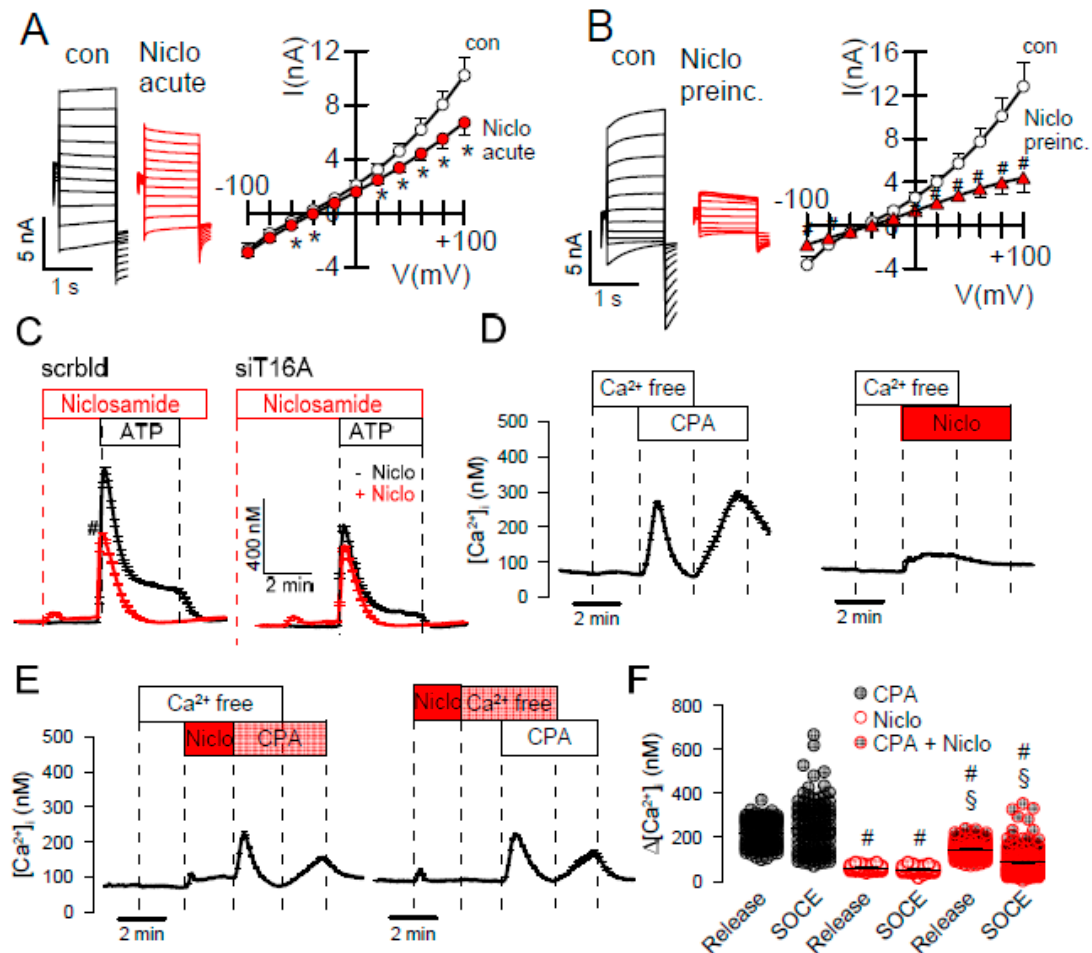
Figure 4. Niclosamide inhibits TMEM16A currents activated by intracellular Ca 2 + . (A ) TMEM16A overexpressed in HEK293 cells was activated by 1 µ M Ca 2 + in the patch pipette filling solution. Acute application of niclosamide (Niclo; 5 µ M) significantly inhibited Ca 2 + -activated TMEM16A whole cell currents ( n = 7). ( B ) 15 min preincubation with Niclo inhibited TMEM16A more potently ( n = 9–10). ( C ) Increase in intracellular Ca 2 + with ATP (100 µ M) in HT 29 cells. Niclosamide (5 µ M) induces a slight and transient increase in [Ca 2 + ] i and inhibits ATP-induced rise in [Ca 2 + ] i . siRNA knockdown of TMEM16A inhibits increase in [Ca 2 + ] i by ATP. Niclosamide shows no additional e ff ects on [Ca 2 + ] i ( n = 60–193). ( D ) ER Ca 2 + store release and Ca 2 + influx (SOCE) induced by CPA and niclosamide ( n = 40–50). ( E , F ) E ff ects of CPA and niclosamide on Ca 2 + store release and SOCE under various conditions ( n = 40–213) * significant inhibition ( p < 0.05; paired t -test). # significant inhibition ( p < 0.05; unpaired t